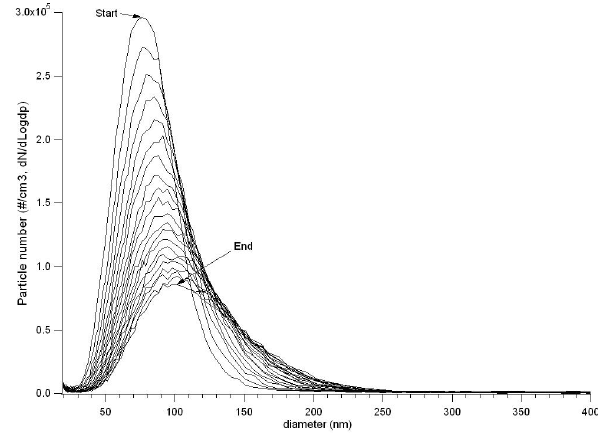
Fig. 8. Temporal evolution of the size distribution of produced SOA. Between the beginning and the end of this experiment, the mean diameter of the measured size distribution was shifted from 80 to 100nm with maximum number concentrations of 4 × 10 3 to 1 × 10 3 particlescm − 3